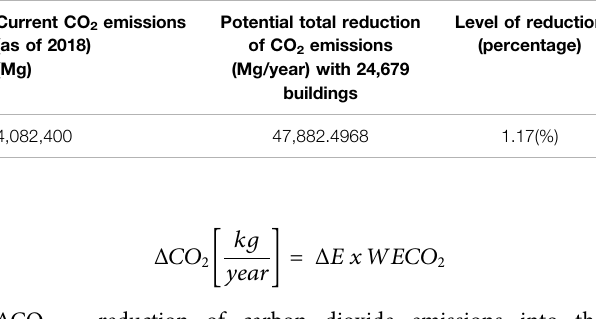
TABLE 8 | Comparison of potential reduction of CO 2 emissions generated by coal- fi red power plantswiththecurrent annual CO 2 emissions generated by3 power plants/combined heat and power plants in Ma ł